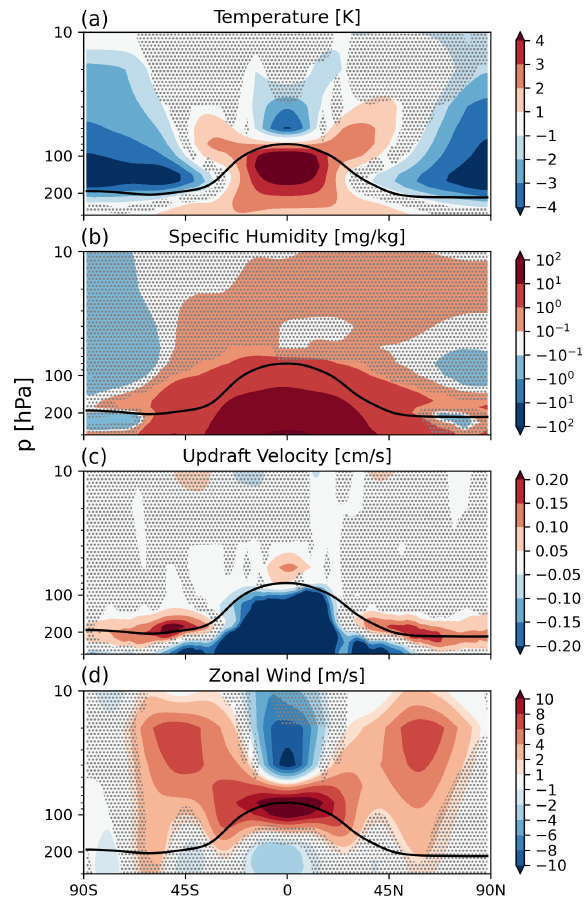
Figure 12. Five-year zonal mean anomalies of (a) temperature in K, (b) specific humidity in mgkg − 1 , (c) updraft velocity in cms − 1 , and (d) zonal wind in ms − 1 for D19 with a seeding particle con- centration of 100INPL − 1 . Anomalies are only shown for the up- per troposphere and the stratosphere between 300 and 10hPa. The black line is the 5-year mean zonal mean WMO-defined tropopause height at pressure levels. The stippling in the difference plots shows insignificant data points at the 95% confidence level according to the independent t test controlled by the false discovery rate